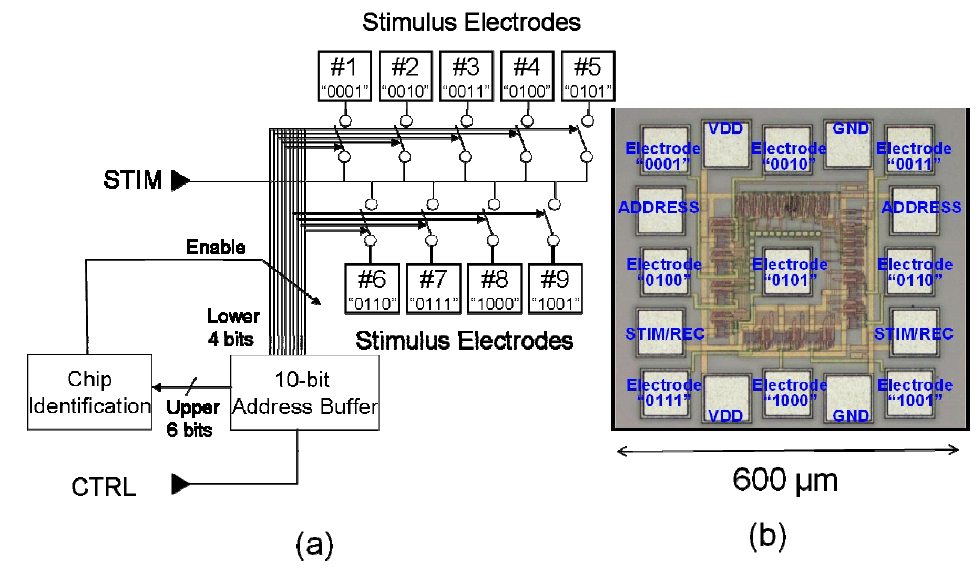
Figure 11. Block diagram (a) and microphotograph (b) of the microchip (adapted from